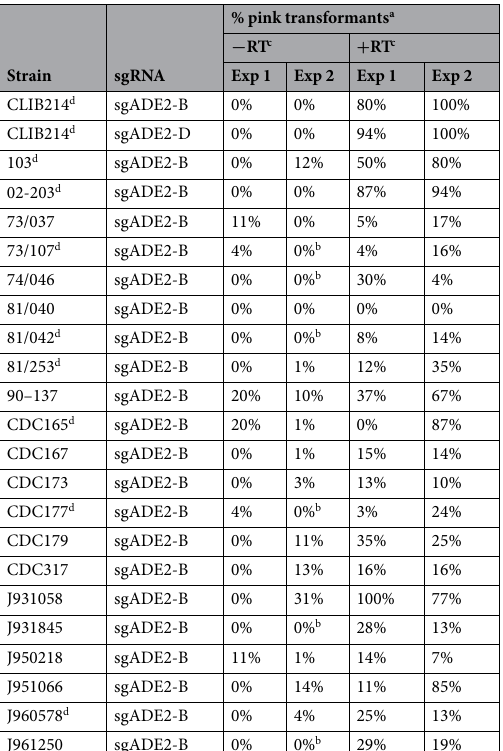
Table 1. Efficiency of CRISPR-based editing of ADE2 in multiple isolates of C . parapsilosis . a Transformation efficiencies from two experiments performed by two people. 81/040 and CLIB214 were transformed several times and the results from two experiments are shown. b < 1% pink colonies. c RT = repair template. d Isolates sequenced to confirm mutation (Fig.